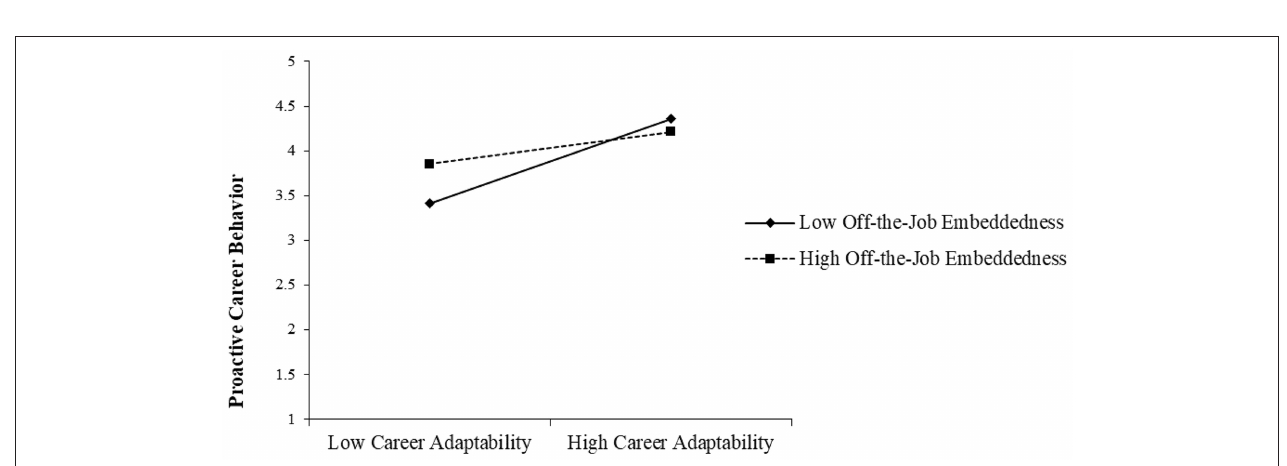
FIGURE 2 | The effect of career adaptability on proactive career behavior at high and low levels of on-the-job embeddedness. The simple slope tests showed that the relationship between career adaptability and proactive career behavior was more positive for individuals with high on-the-job embeddedness ( b = 0.59, p < 0.001) than for individuals with low on-the-job embeddedness ( b = 0.20, n.s. ).